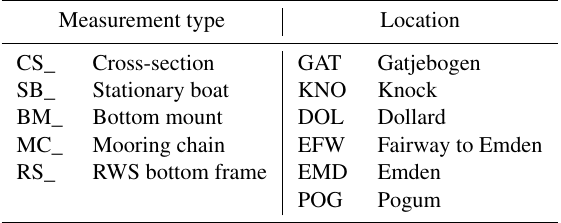
Table 1. Explanation of abbreviations for survey type and location. At one specific location multiple measurement types may be